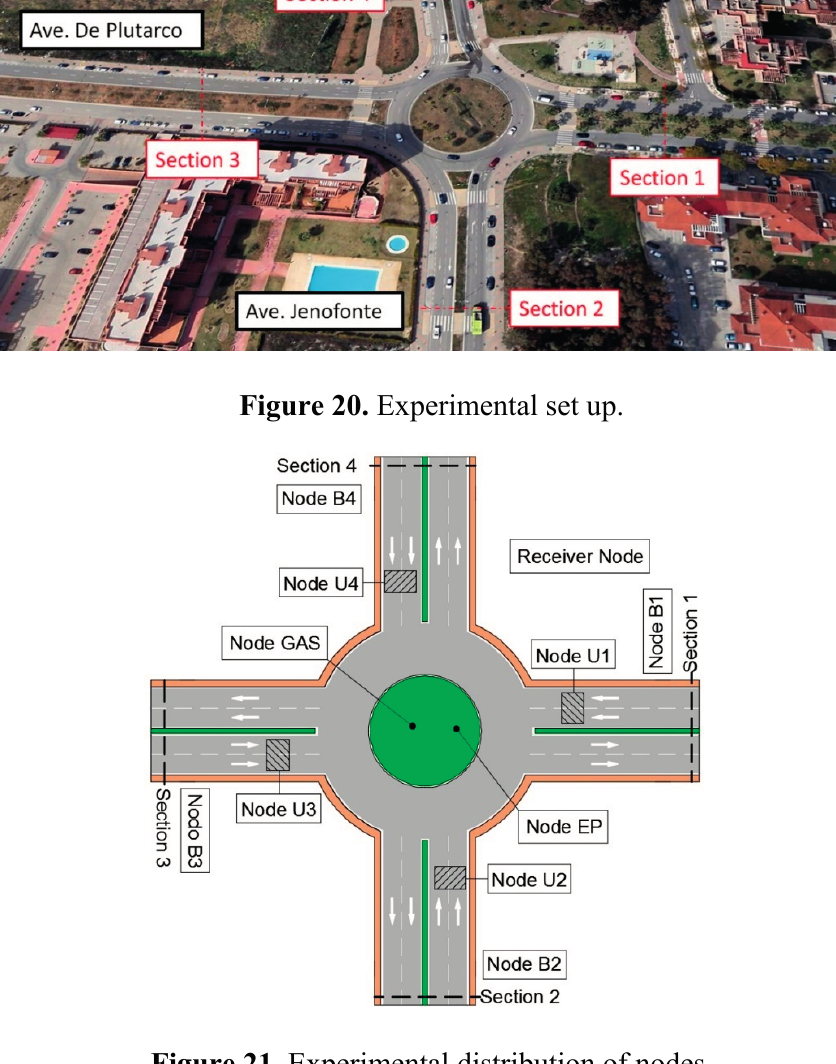
Figure 21. Experimental distribution of